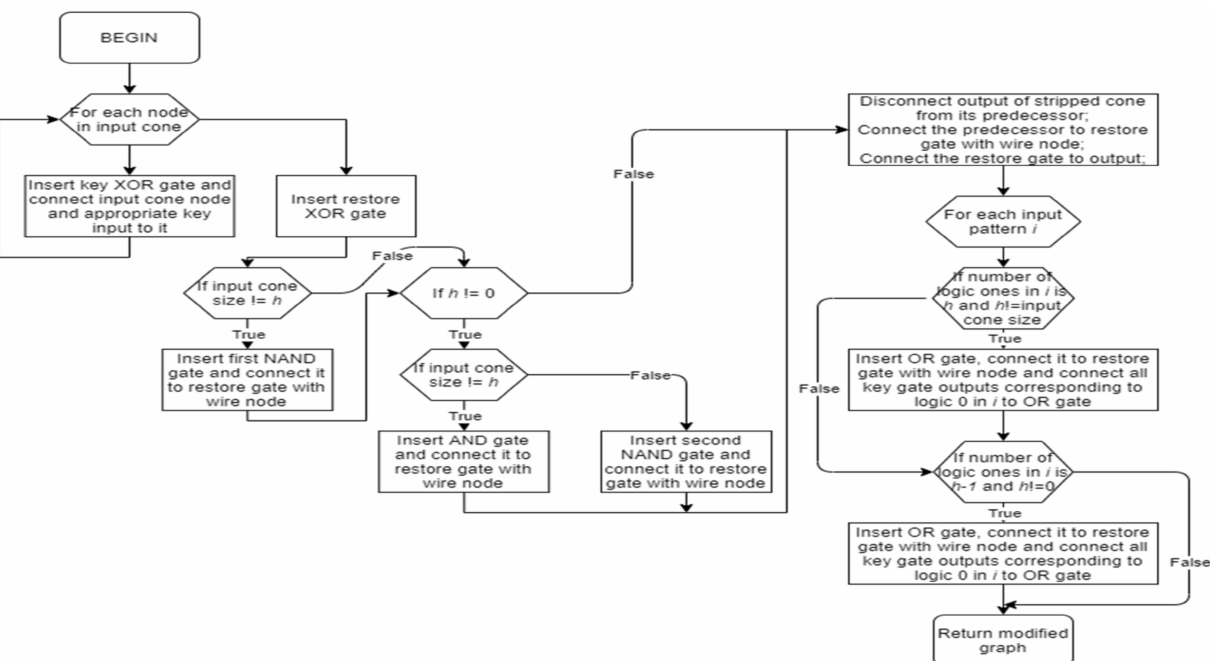
Figure 6. The functionality restores the function